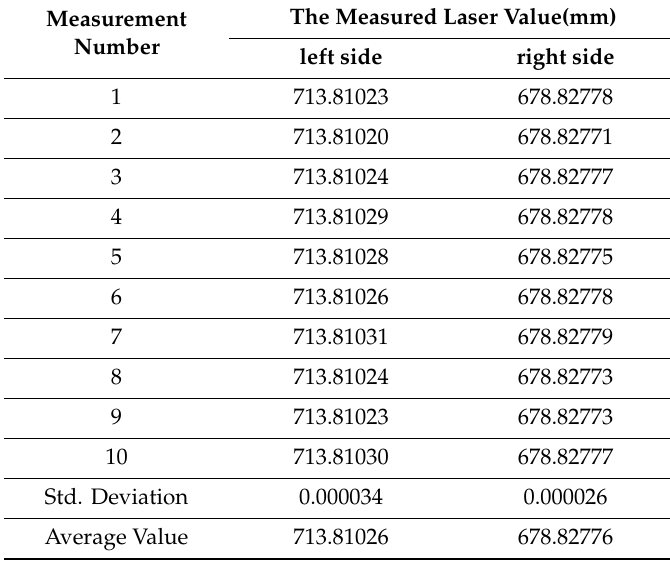
Table 1. The measurement results for calibrate the diameter of the CMM probe.